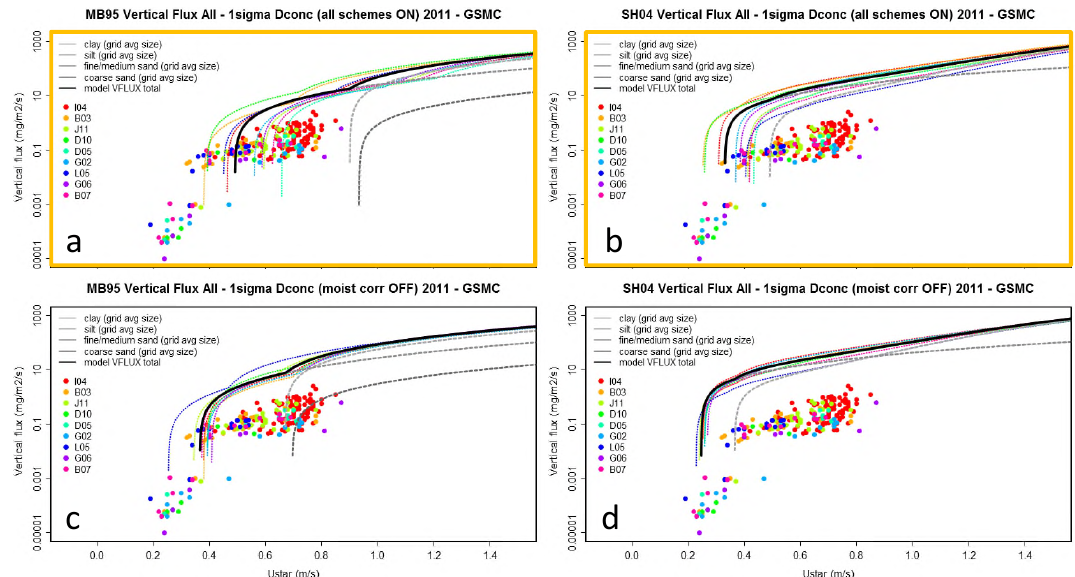
Figure 8. Vertical emission flux for Exps. 1a, b (a, c) , and 4a, b (b, d) . Coloured circles are the observed fluxes. The simulated grid average flux is shown in black. The fluxes of the individual field sites are complementarily given by the dotted coloured lines. The dashed grey lines refer to the model particle size categories as specified on the top left, with fine/medium sand being emitted first (compare Fig.